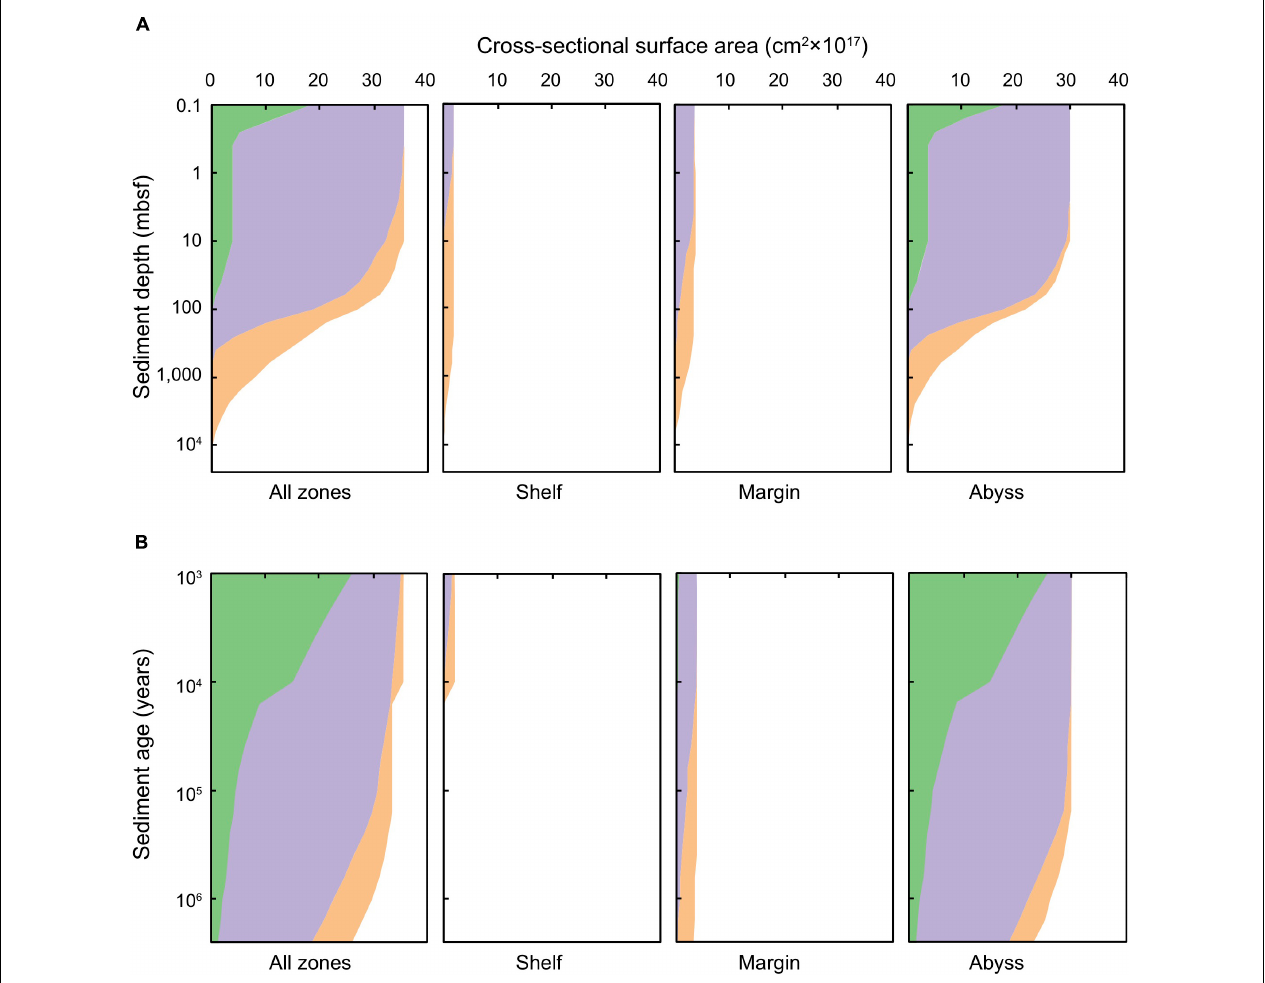
FIGURE 2 | Cross-sectional surface area of global marine sediments according to (A) sediment depth (0.1 to ∼ 10,000 mbsf) and (B) sediment age (1,000 years to 2.59 million years). Green shading represents oxic sediments, lilac denotes sulfate-reducing sediments, and orange signifies methanogenic